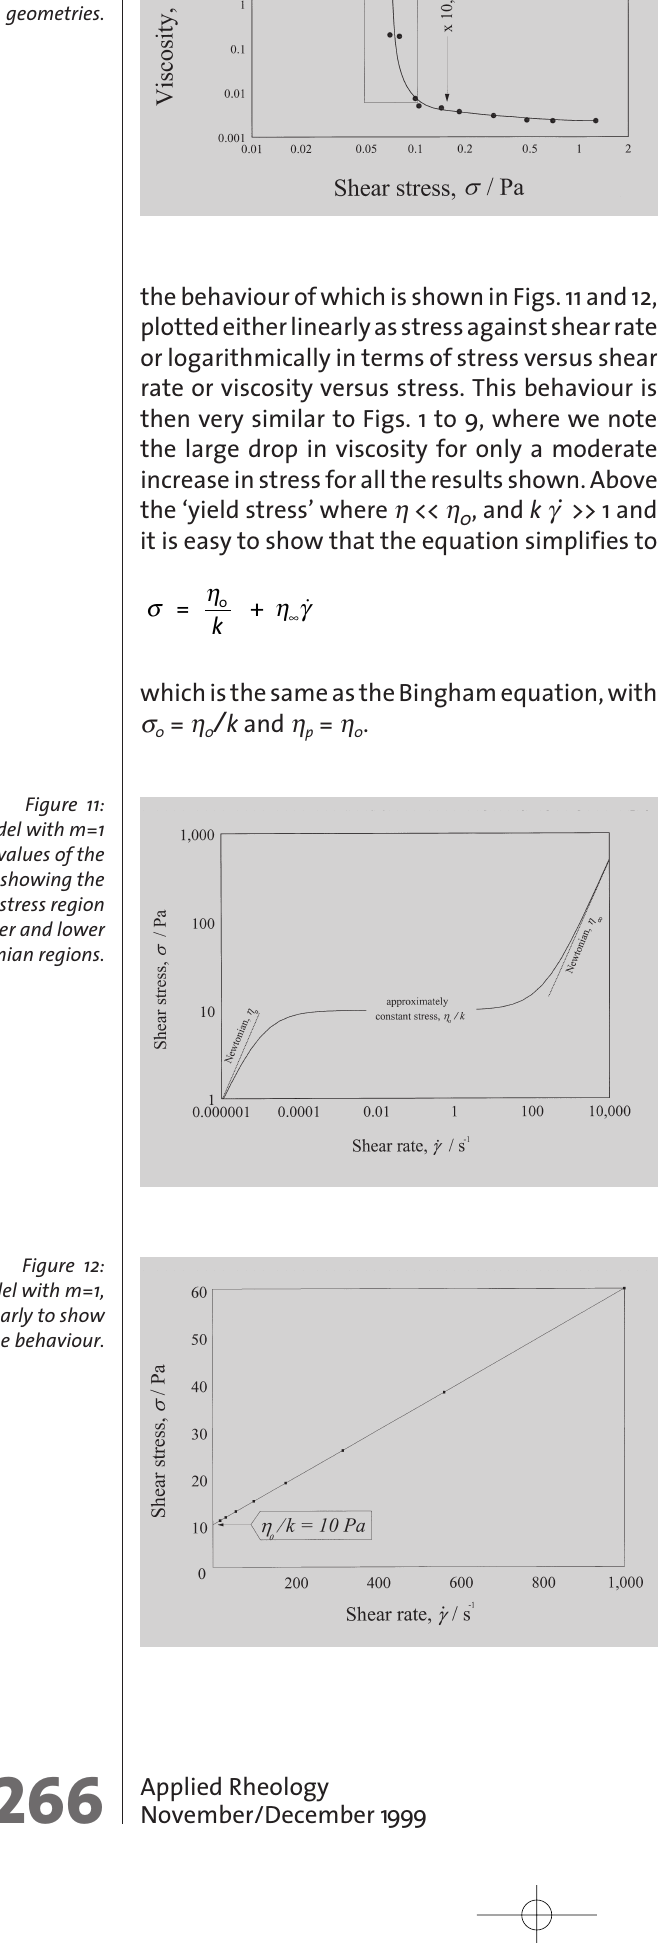
Figure 9 ( left): Flow curve of saliva at room temperature. Figure 10 ( right): The vane and the vane-and-basket geometries.